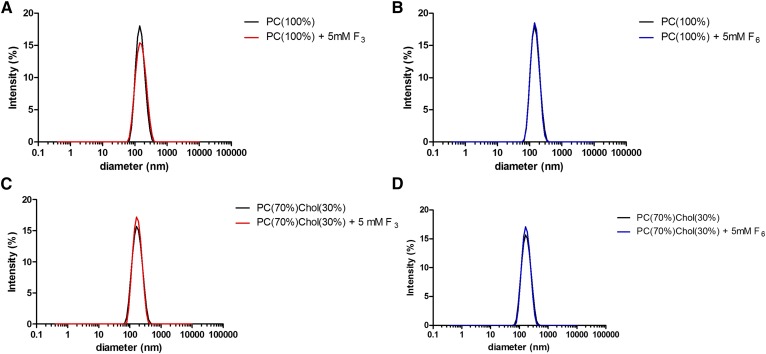
Addition of 5 mM F3 or F6 did not induce liposome aggregation. Dynamic light scattering demonstrates that addition of 5 mM F3 (A, C) or F6 (B, D) did not induce significant aggregation of PC100% (A, B) and PC70%Cholesterol30% (C, D) liposomes after incubation for 30 min at 37°C (n = 3).